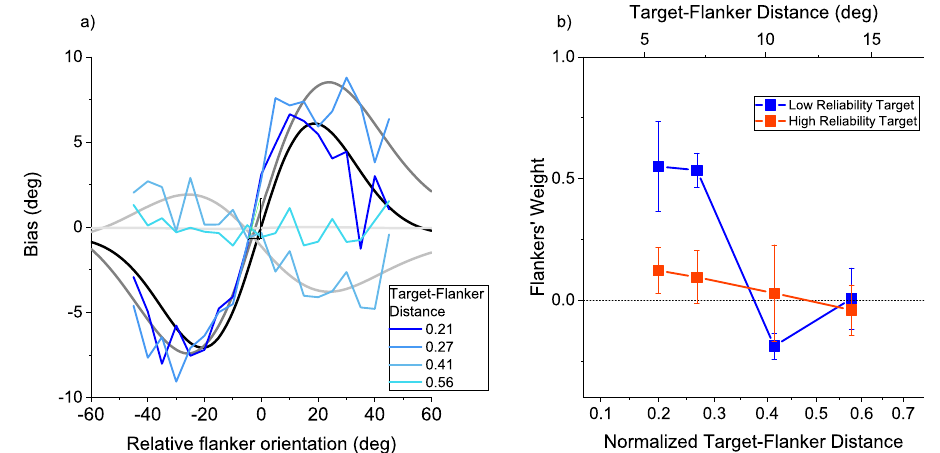
parameters(Eq. 18). b Weight of the fl ankers(maximal slopeof the curves in panel a ) as a function of the normalized target- fl anker distance (colour-code as before). Negative weights imply a repulsive, rather than attractive effect of fl ankers on target. Error bars show ±1 SEM. Source data are provided as a Source Data fi